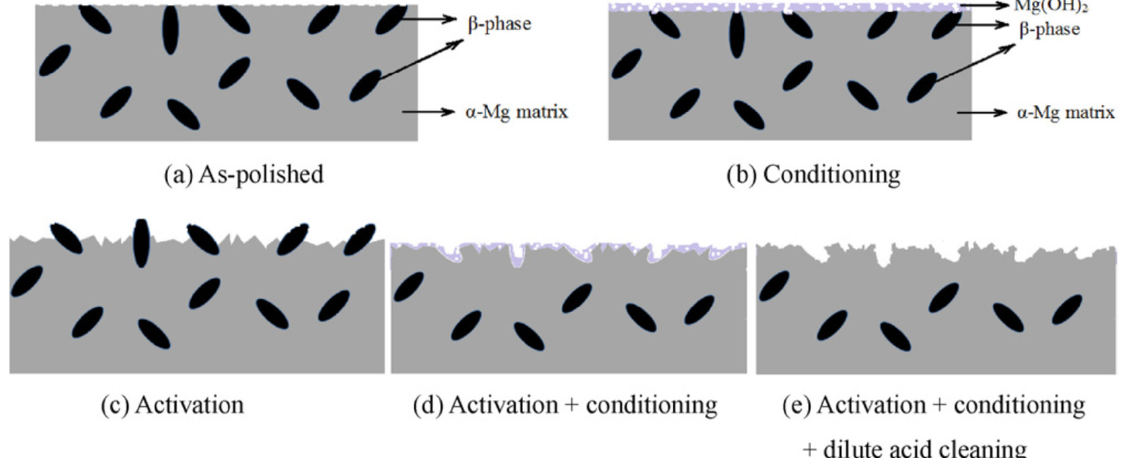
Figure 6 . Schematic representation of the surface after the various pre-treatment processes. “Acti- vation” refers to acid pickling, “conditioning” implies alkaline treatment. Reprinted from [52] with permission from Elsevier.